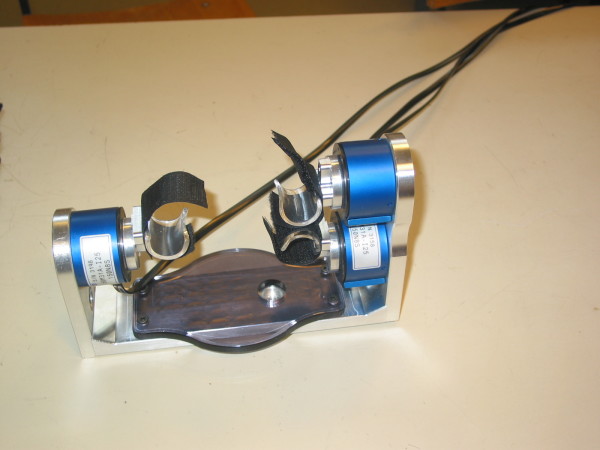
The Finger Device.